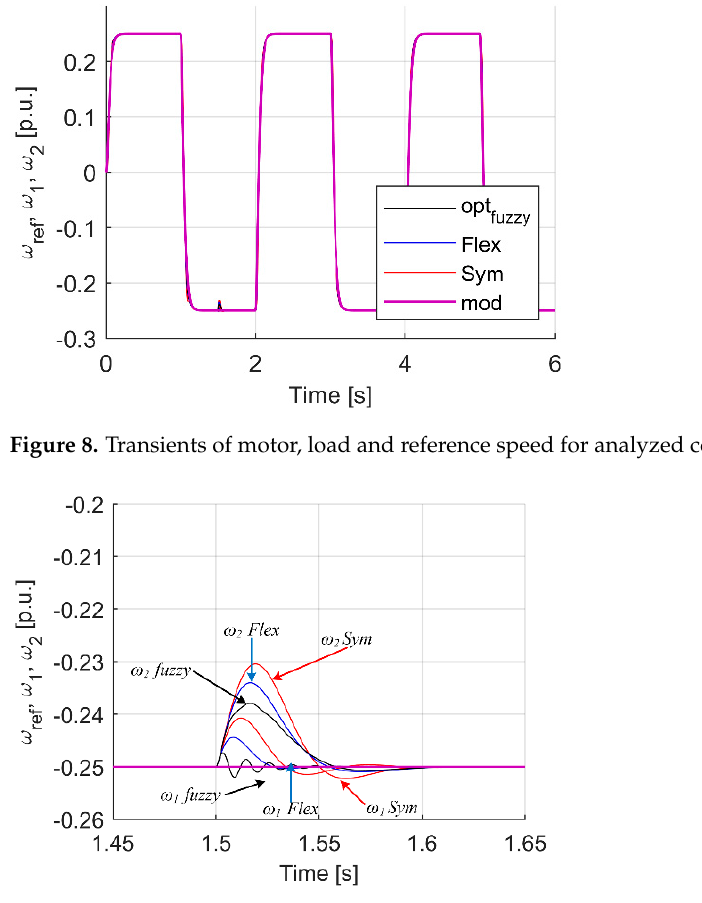
Figure 9. Transients of difference between motor, load and reference speed under torque load change.